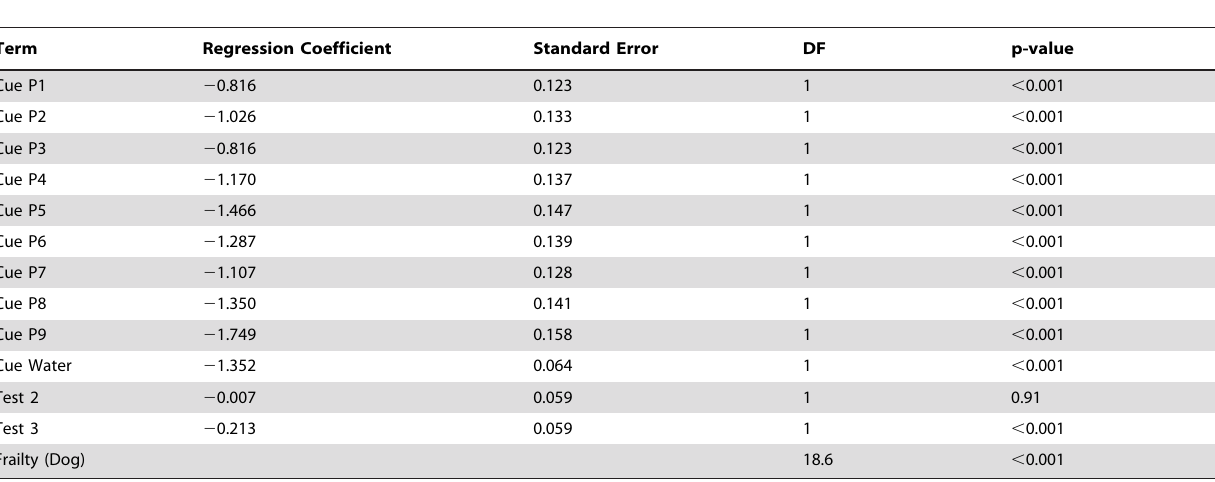
Table 6. The statistical output of the final Cox Proportional Hazards regression